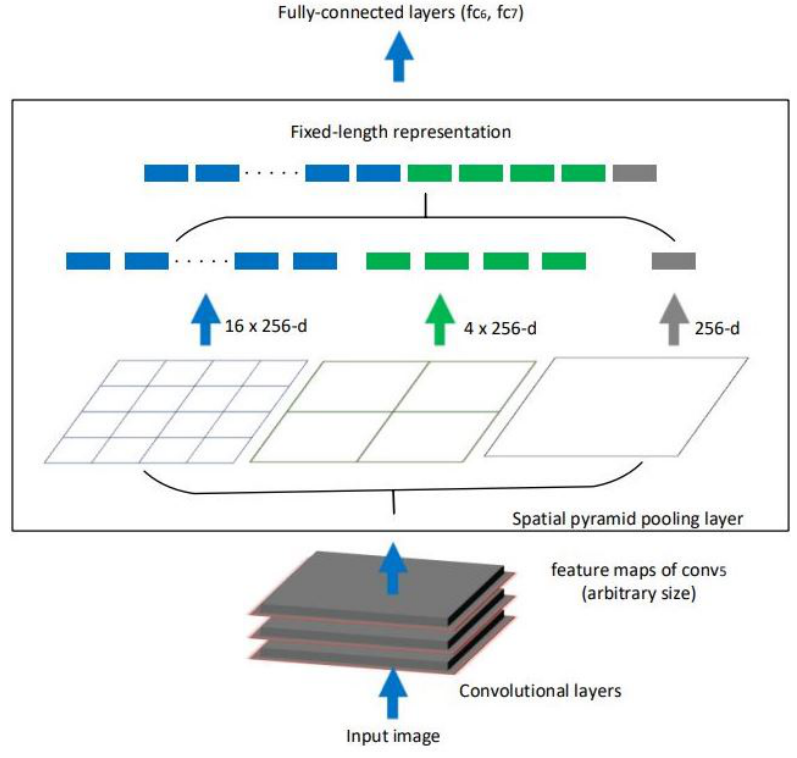
Figure 3. Visualization of SPP, reproduced from